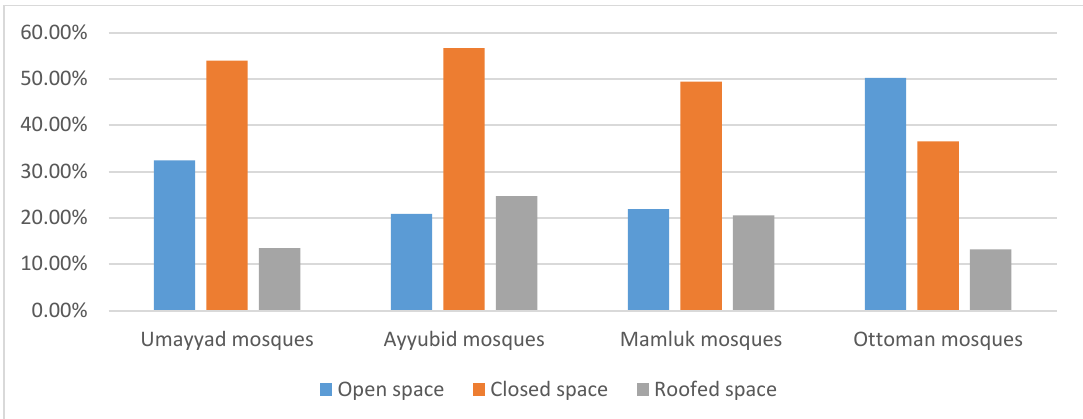
Fig. 5: The share of open, closed, and roofed spaces in the structure of the selected historical mosques